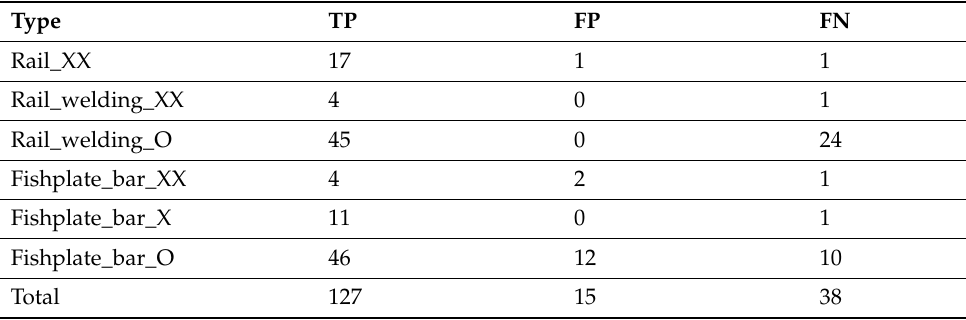
Table 14. YOLOX-Tiny training results for each defective type in the side